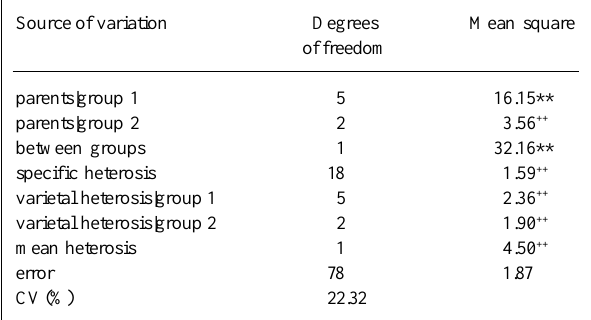
Table V - Summary of the analysis of variance of the partial diallel including nine lines of common beans and their F generations, for grain yield, in 2